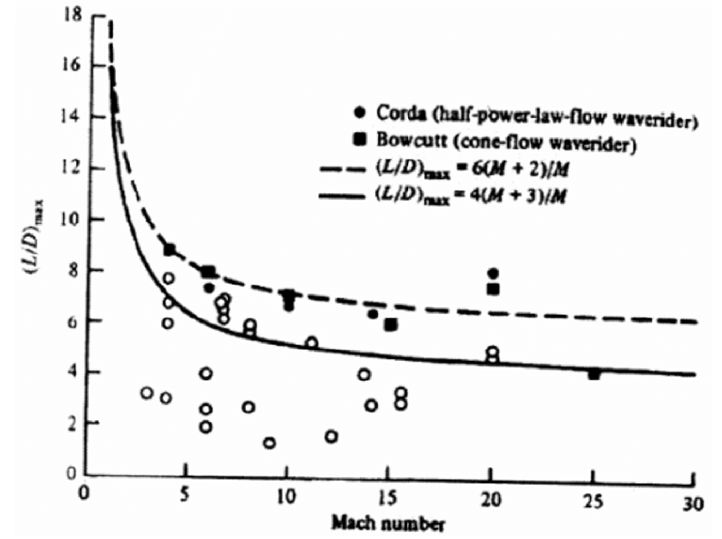
Figure 1. L/D vs flight Mach number. Figure 1. L/D vs. flight Mach